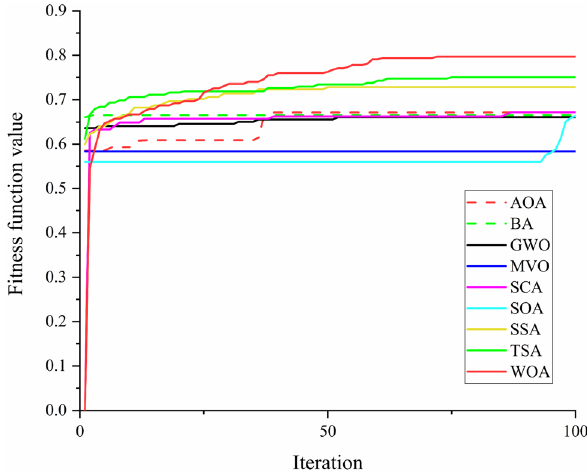
Fig. 12 The ANOVA tests of the algorithms for case 2